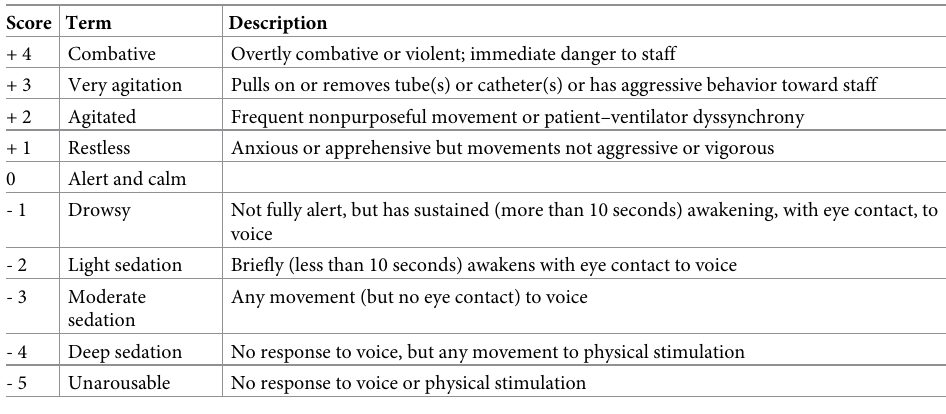
Table 2. Richmond agitation–sedation